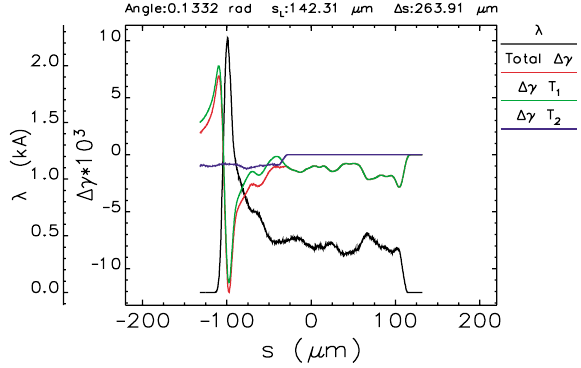
FIG. 8. (Color) Bunch distribution and CSR wakes at the end of the fourth